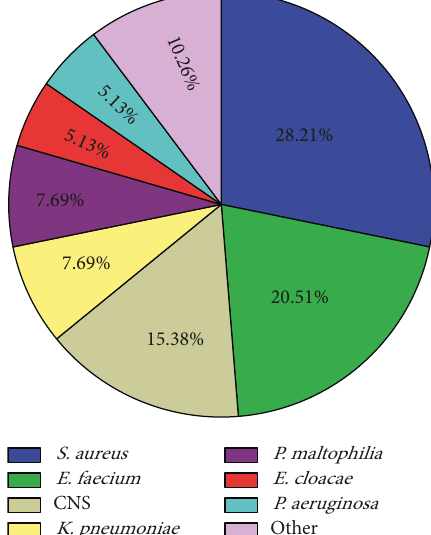
Figure 2: Distribution of the additional organisms in polymicrobial Acinetobacter baumannii bloodstream infections. Abbreviations: S. aureus : Staphylococcus aureus; E. faecium : Enterococcus faecium; CNS : coagulase-negative Staphylococcus; K. pneumoniae : Klebsiella pneumoniae; P. maltophilia : Pseudomonas maltophilia; E. coli : Escherichia coli; P. aeruginos a: Pseudomonas aeruginosa ; Others: